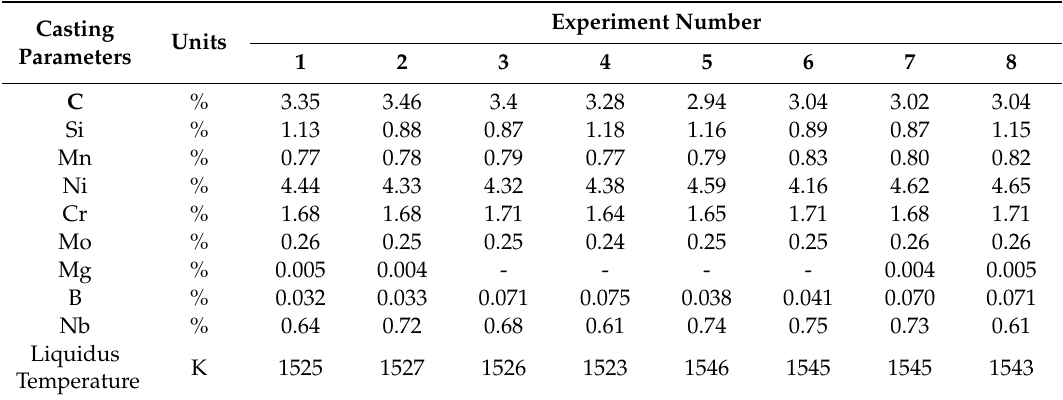
Table 5. Casting parameters in each experiment.